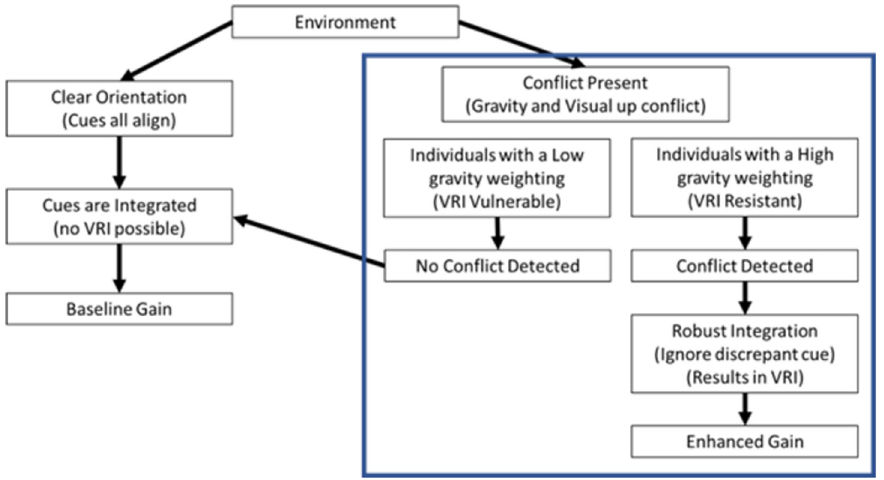
Fig 5. The effect of visual/vestibular conflict on visual gain. A model of how conflict between visual and vestibular cues to orientation might affect the gain of perceived motion. Within the blue box are two groups of participants, those with relativity high gravity weights (right), and those with relatively low gravity weights (left). The model indicates how the relative weights might alter perceived travel distance. The left side of the diagram indicates the situation when all cues are